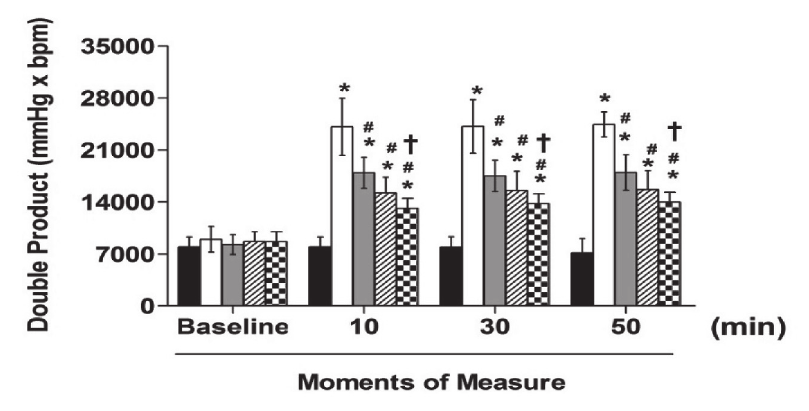
Figure 3 - It shows the values of the double product of the sessions. Note:*statistical difference between the time of measurement of heart rate during exercise and their resting values # difference between the values during exercise compared to aerobic exercise. †difference between the moments of measures compared to resistance exercise. Signi fi cant difference on value of p <